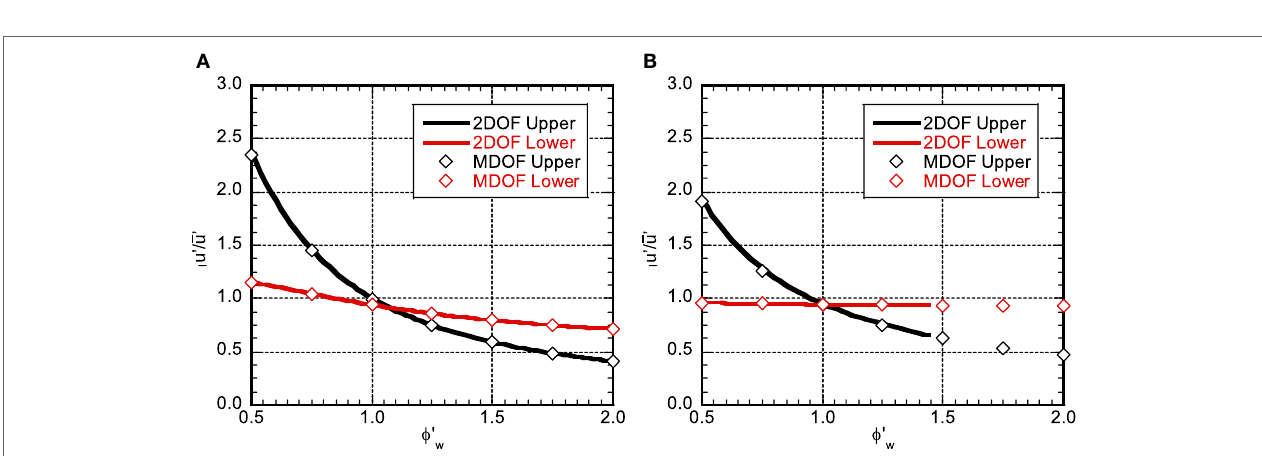
FIGURE 14 | Maximum story drift angle ratio (variable: D (D) lower structure ( H w / H :0.5).